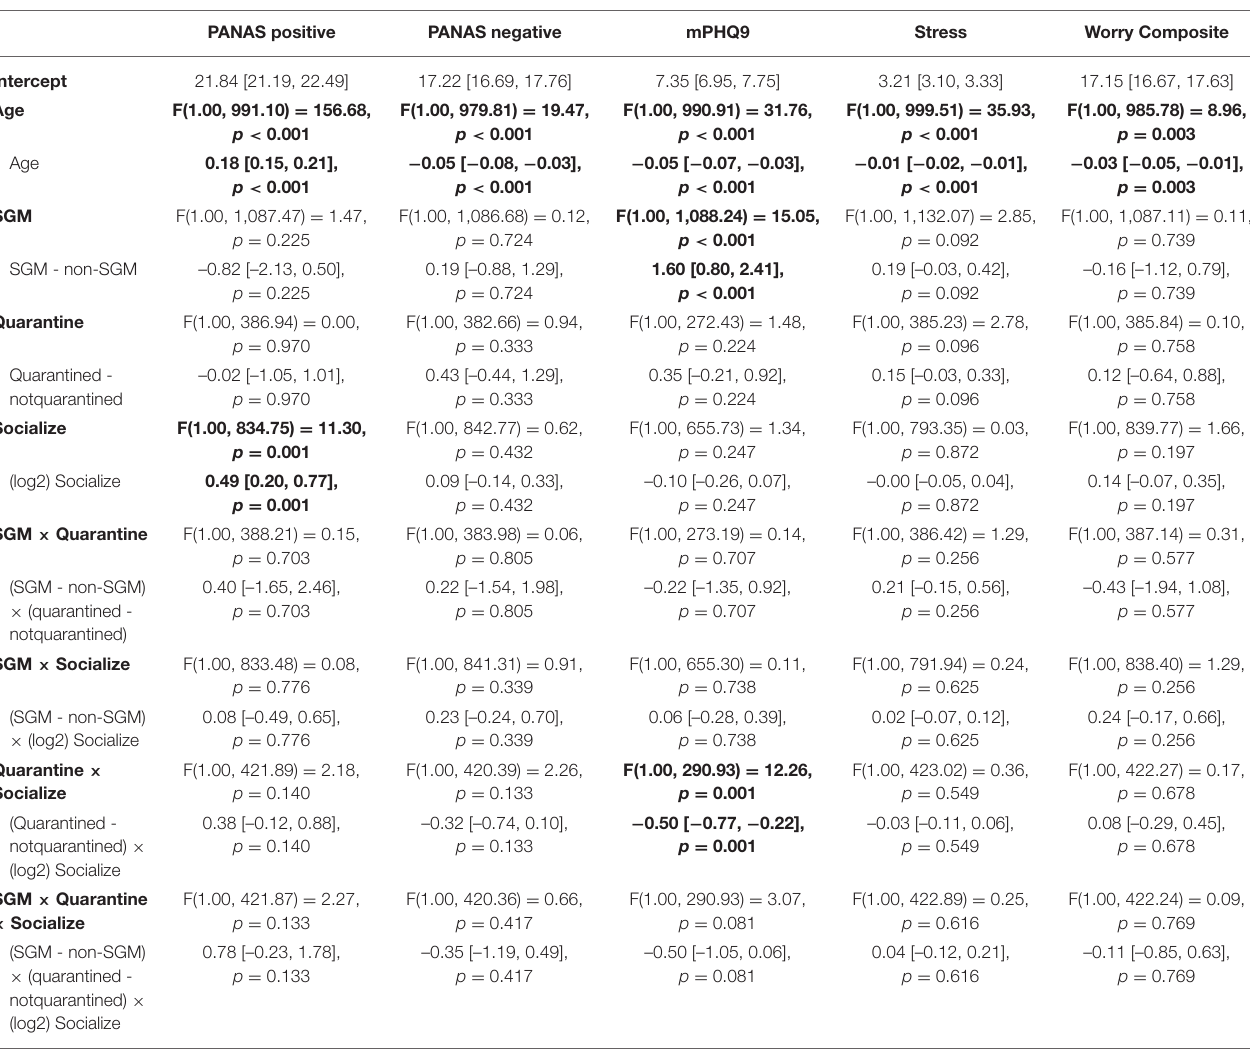
TABLE 5 | Model 4 regression